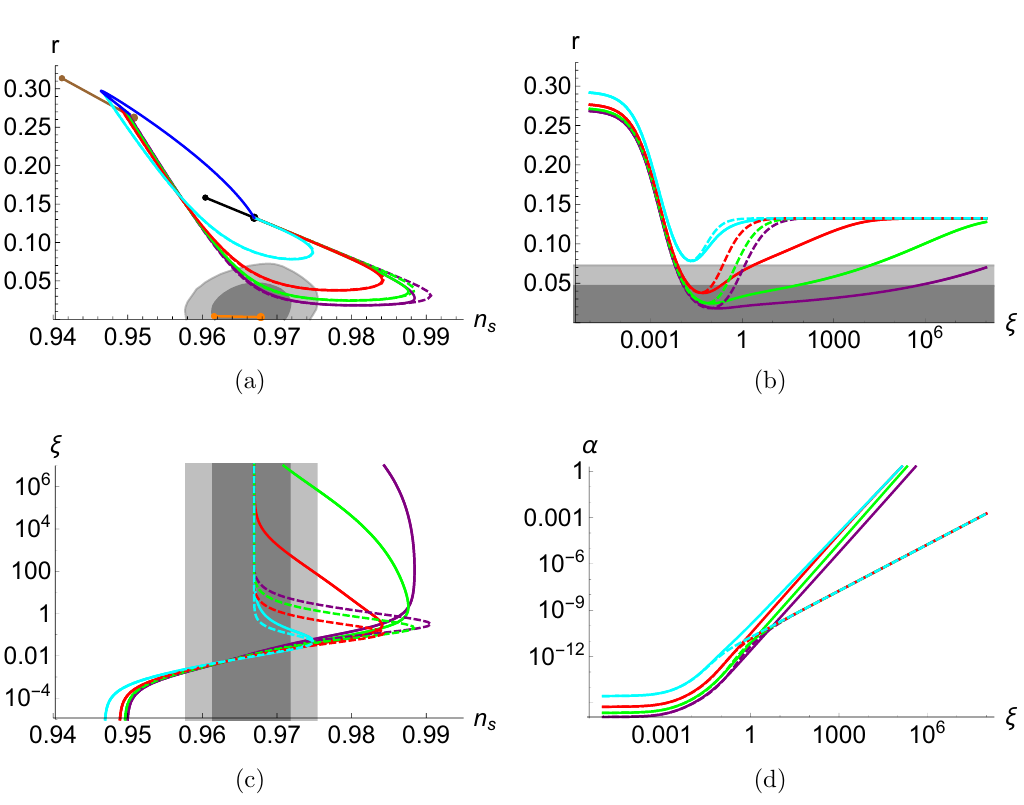
Figure 13. r vs. n s (a), r vs. ξ (b), ξ vs. n s (c) and α vs. ξ (d) for δ = 10 − 6 , 10 − 4 , 10 − 2 , 1 respectively in purple, green, red and cyan with N e = 60 e -folds in region 3. Continuous/dashed line represents metric/Palatini gravity. For reference we plot the predictions of CW inflation for N e = 60 (blue), R 2 (orange), χ 2 (black) and χ 4 (brown) inflation for N e ∈ [50 , 60] . The gray areas represent the 1,2 σ allowed regions from Planck 2018 data [6].